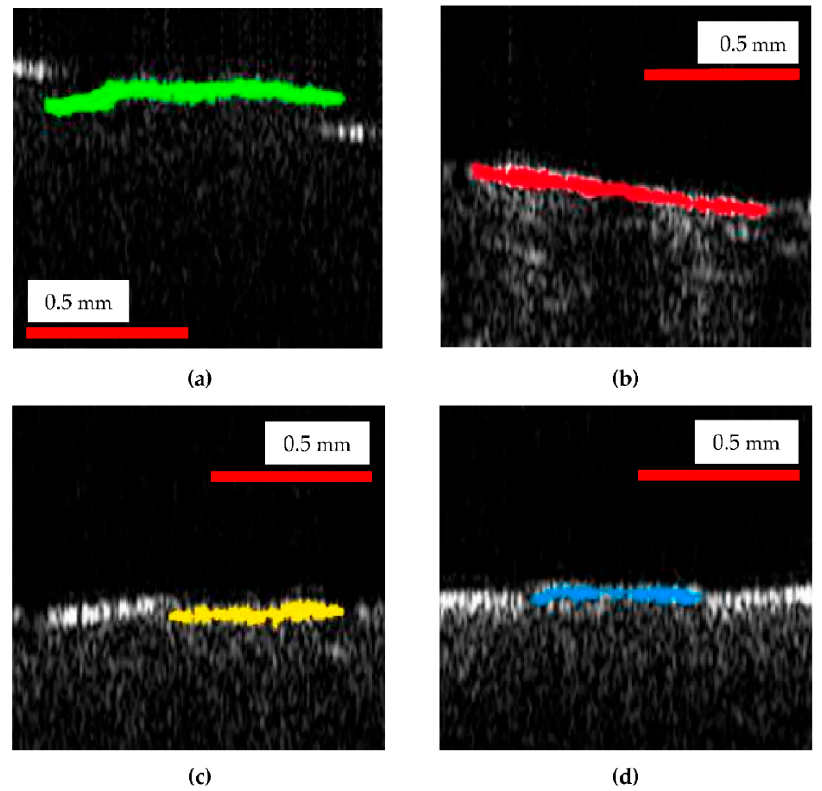
Figure 8. Details of OCT B-scans from each of the sample plates from: ( a ) the control group; ( b ) top plate; ( c ) middle plate; ( d ) bottom plate. The dimensions of each image are 0.92 (lateral) × 0.95 (vertical, along depth measured in air) mm 2 . The lengths in green, red, yellow and blue correspond to the length along the upper contour of the B-scans of each group between two consecutive gaps, as observed in Figure 7.